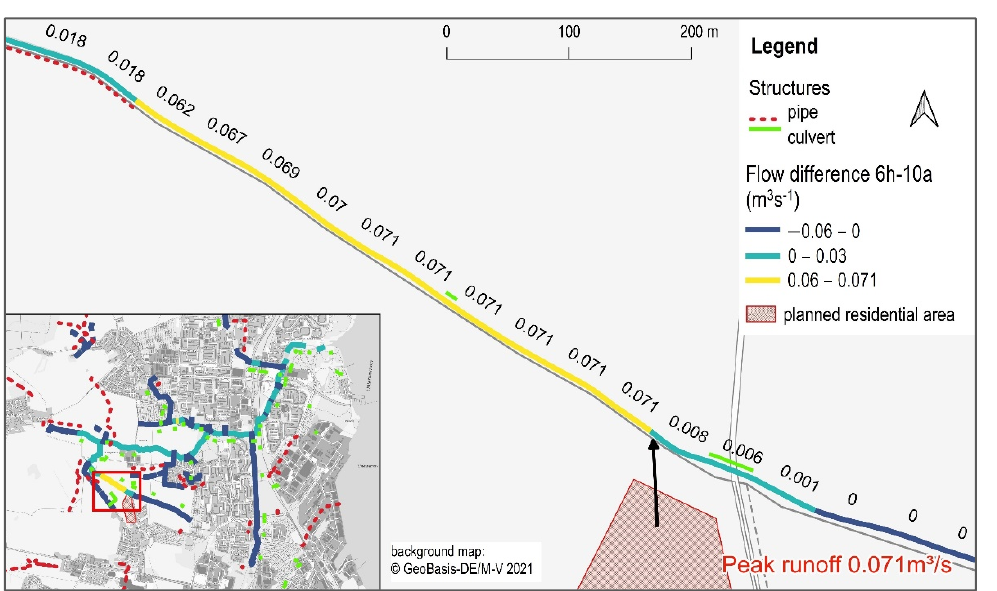
Figure 8. Flow difference (m 3 s − 1 ) in the immediate area of the discharge point for the rain event 6 h–10 a (pipes and culverts are plotted with offset to original route).